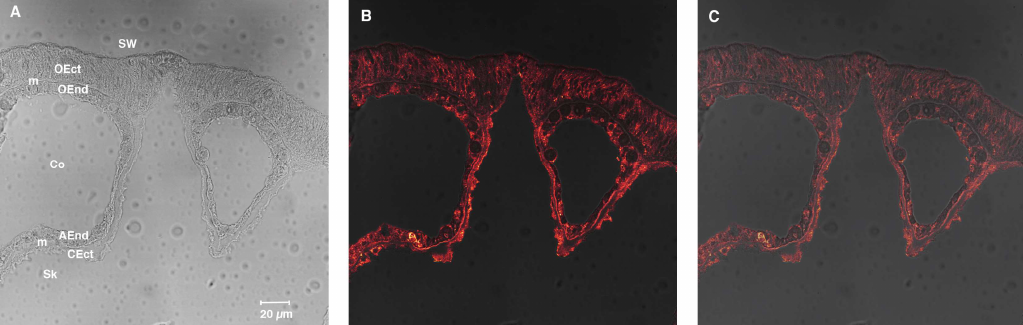
Figure 4. Immunolocalization of SpiCA3. Embedded cross-section of Stylophora pistillata tissues labeled by anti-SpiCA3. Panel ( A ) shows light transmission of the cross-section, ( B ) shows anti-SpiCA3 revealed by streptavidin AlexaFluor 568 secondary antibody that appears in orange ( C ) merges Panel ( A and B ). AEnd = Aboral Endoderm; CEct = Calcifying Ectoderm; Co = Coelenteron; m = Mesoglea; OEct = Oral Ectoderm; OEnd = Oral Endoderm; Sw = Seawater; Sk = Skeleton. The objective was 40× oil immersion.